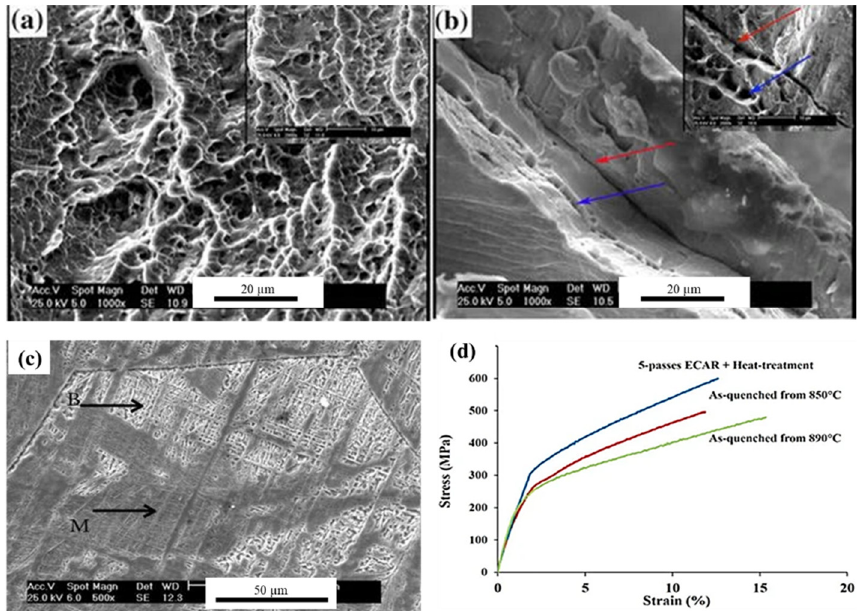
Figure 6. Cu–8.3Al–8Mn alloy after five passes of the ECAR process and post-deformation annealing, ( a ) fracture surface after the tensile test for the as-received sample, and ( b ) five-passes ARB and heat-treatment; ( c ) SEM microstructure after five passes of ECAR and post-deformation annealing heat treatment including β grains and martensite; ( d ) room-temperature stress-strain curves under different processing conditions, adapted with permission from [72], 2022, Springer Nature.